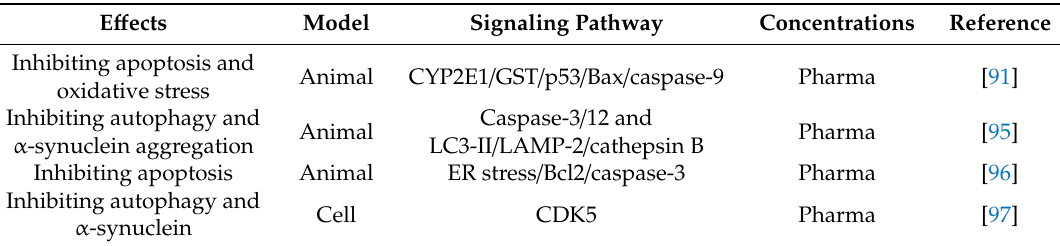
Table 2. Melatonin and Parkinson’s